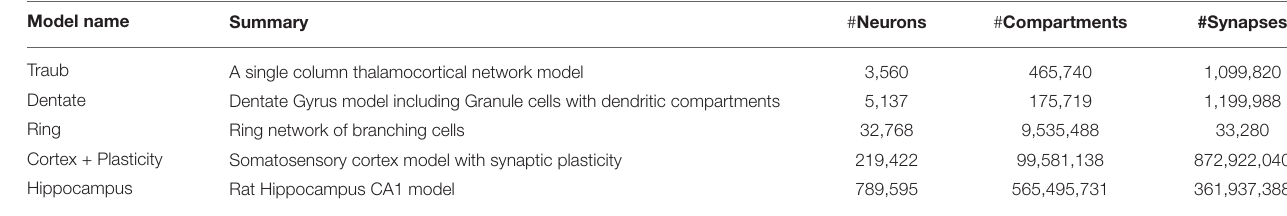
TABLE 1 | Summary of network